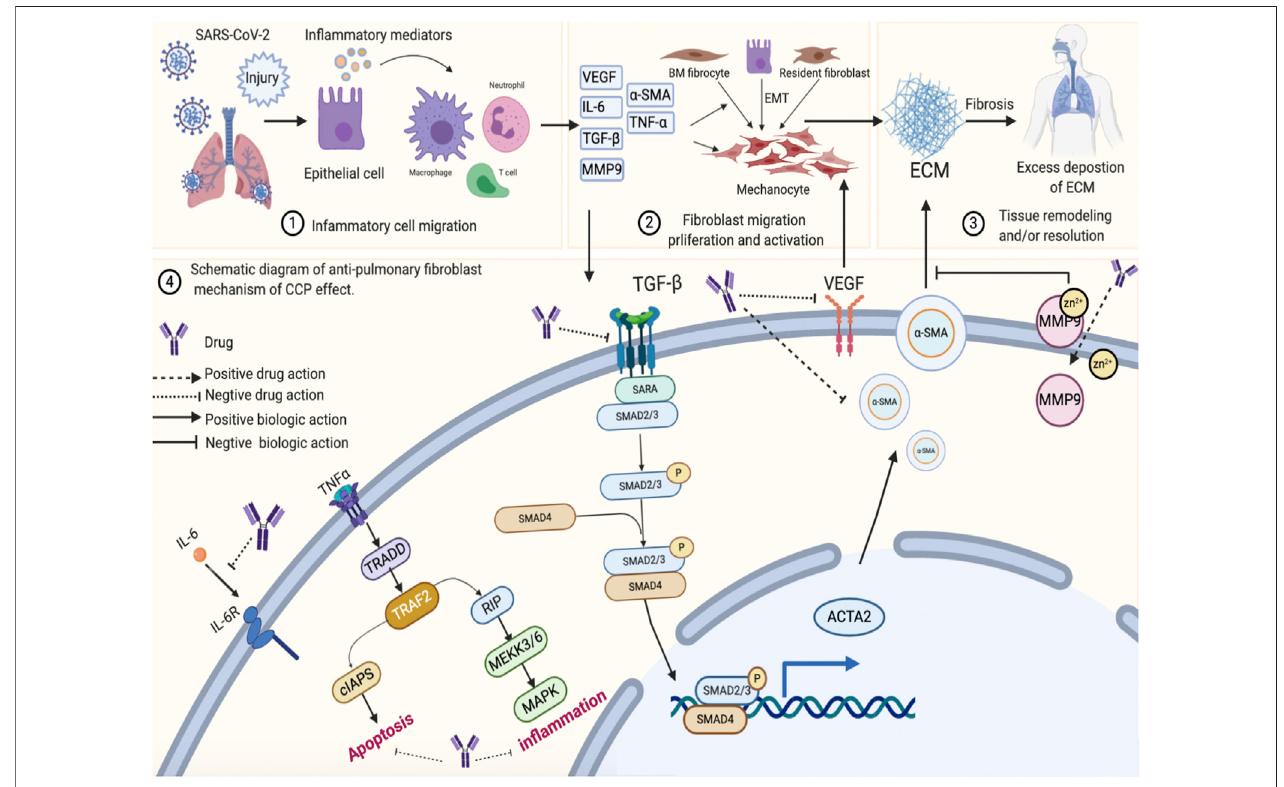
FIGURE 8 | The schematic diagram illustrating the proposed activity model of Convalescent Chinese prescription (CCP) in pulmonary fi brosis. Exposure to SARS- CoV-2 infection damages lung epithelial cell, resulting in injury or cell death and the release of in fl ammatory mediators into the extracellular space. This signal is recognizedbyMacrophagescell,Tcell,Neutrophilscell.Activationofthesecellsleadstoin fl ammatoryresponsesinlungepithelialcell.Lunginjuryalsoinduces fi broblast migration proliferation and activation. These processes result in tissue remodeling or resolution and excess deposition of extracellular matrix (ECM). Chronic, unresolved lung in fl ammation owing to the activation of various signaling pathways (such as TNFa, MAPK and TGF β ) eventually results in progressive lung fi brosis.